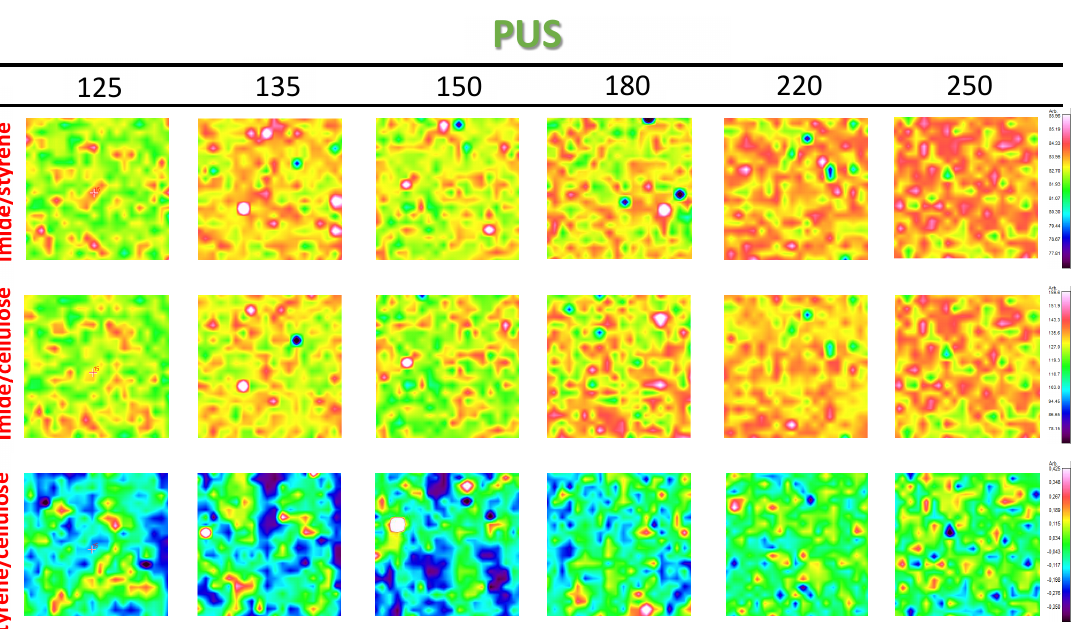
Figure 11 Figure 10. Raman spectroscopy surface maps of SMI/SfO-MUS coatings (1 × 1 mm 2 ), representing band intensity ratio of imide/styrene, imide/cellulose, styrene/cellulose (same intensity scale per row).